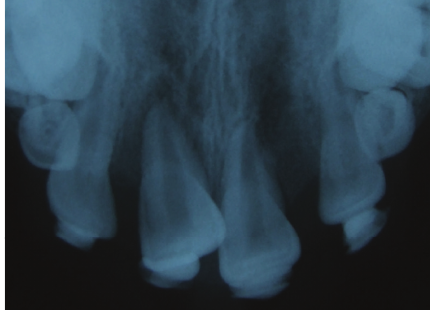
Figure 4: Radiographic view of the autotransplanted incisor at the 3rd week.